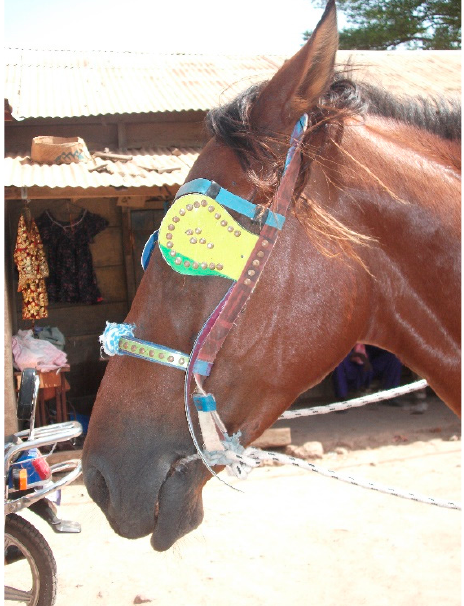
Figure 4. Use of rope in place of a bit in a cart horse in Senegal.